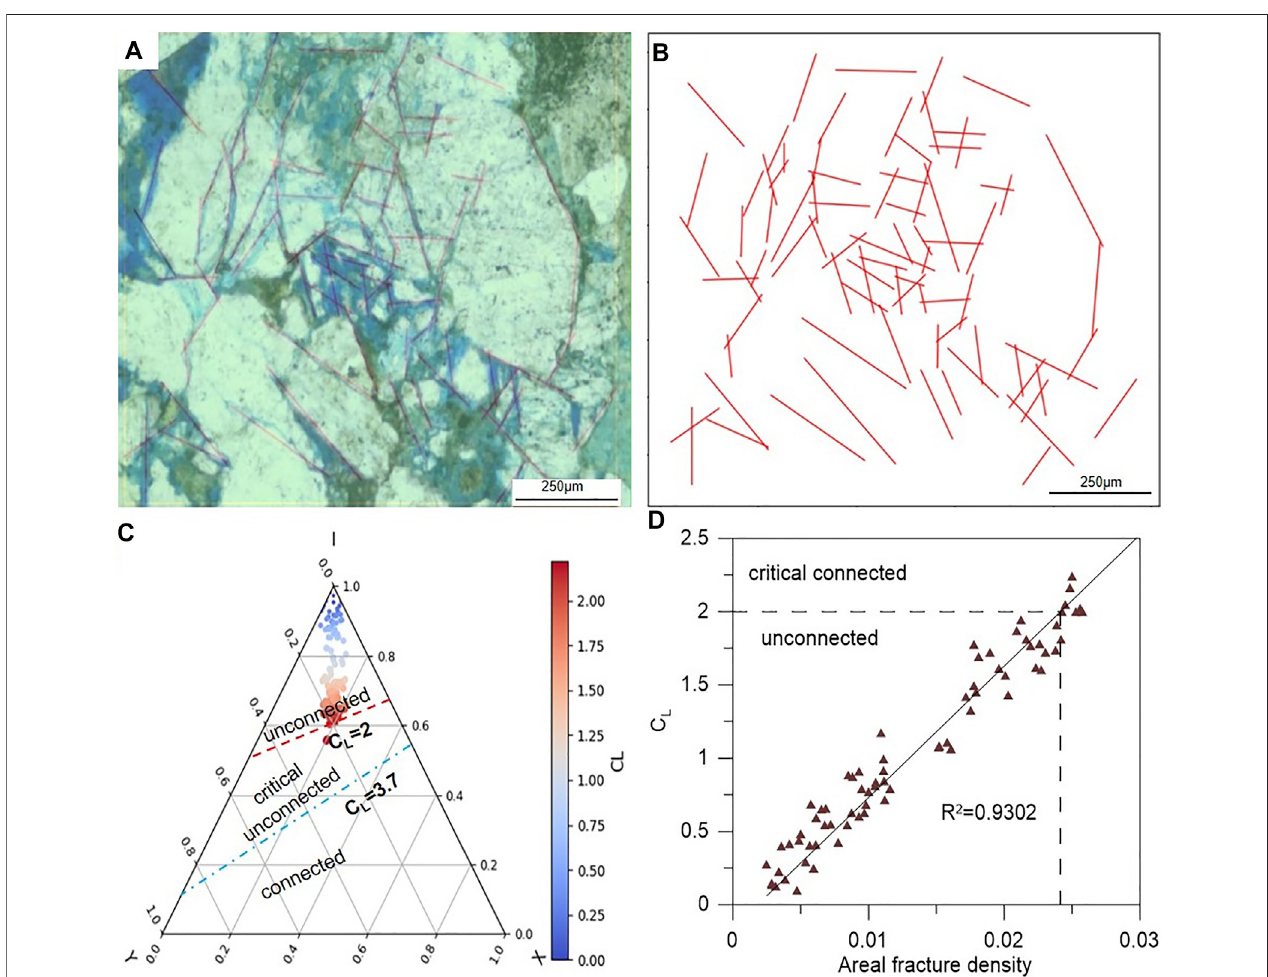
FIGURE14| Characterizationofnaturalfractureconnectivityinlow-permeabilitysandstonesinLD-Agas fi eld. (A) SpatialtopologicalrelationoffracturesinwellLD- A-2-1,depthof4,093.70 m, (B) thefractureconnectivitycharacterizationof (A) , (C) thetypeoffracturenodeandfractureconnectivitycharacterizationofsamplesinLD- A gas fi eld, and (D) the relationship between area fracture density and fracture connectivity.